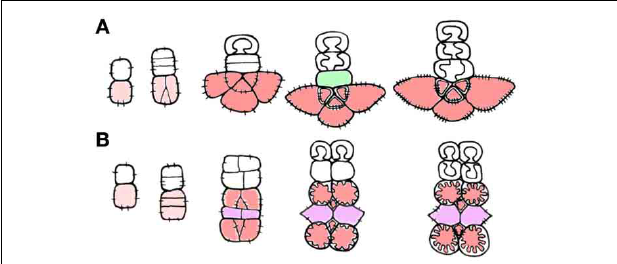
FIGURE 2 | Schemes showing cell division planes in course of minor vein development [redrawn from Gamalei (1990)]. (A) type 1; (B) type 2. Phloem initial cell and mother cell of the phloem complex are shown in pink, SE-CCCs are shown in red, and phloem parenchyma cells are shown in purple. The vascular parenchyma is shown in